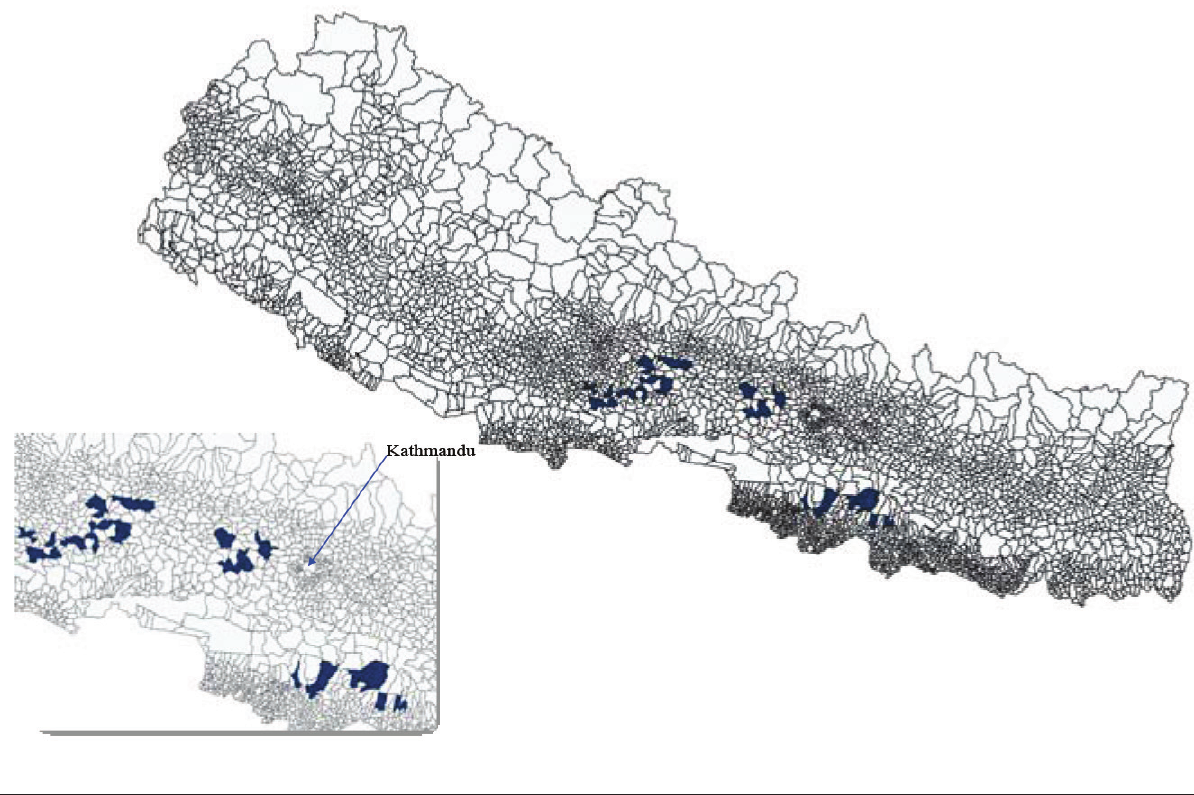
Village development committees representing seven districts in our